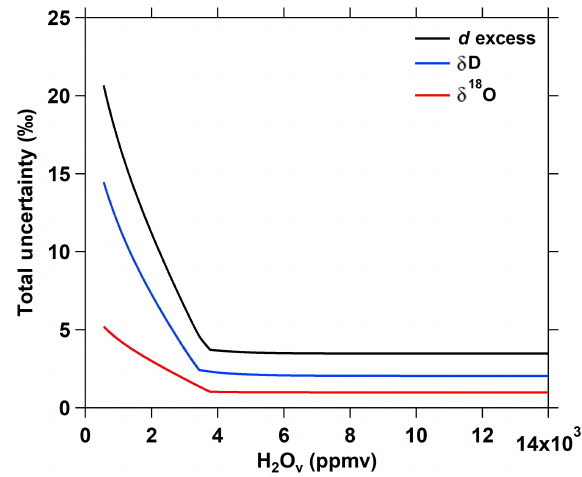
Figure 1. Total uncertainty of δ D, δ 18 O, and d excess over the range of H 2 O v mole fractions observed in